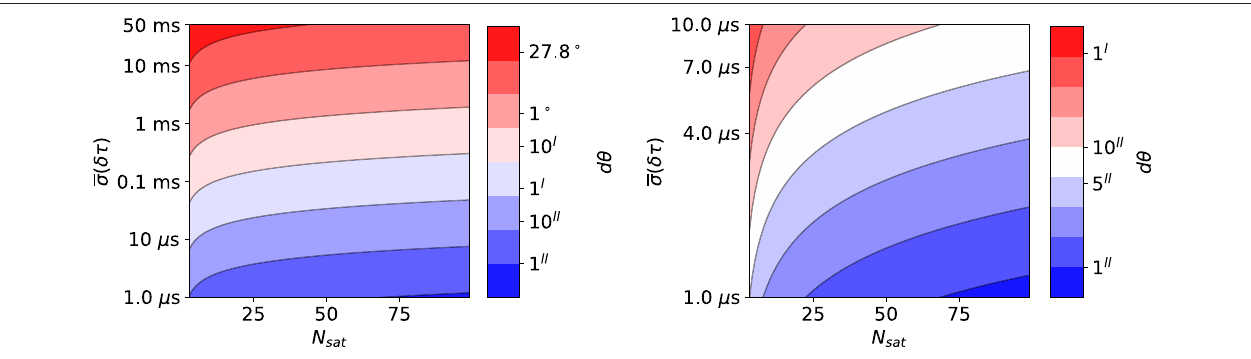
FIGURE 4 | Left panel shows the relationship among mean uncertainty in the time delay of the satellites (log-scale) for the range between 1 μ s and 50 ms, mean uncertainty in position accuracy (log-scale), and average number of satellites. The right panel shows the same relationship for mean uncertainty in the time delay among the satellites between 1 and 10 μ s. The accuracies are calculated using Eq. 7 .